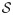
Number of donor HSCs attaching to the BM of a non-preconditioned host after a single dose (dashed lines) or seven daily doses (solid lines).Both treatments use the same total number, S, of donor HSCs. Trajectories are from numerical integration of the ODEs Eq (2). Here we have ℓ = 3 minutes, s* = 100, and the remaining parameters are as in Table 1.